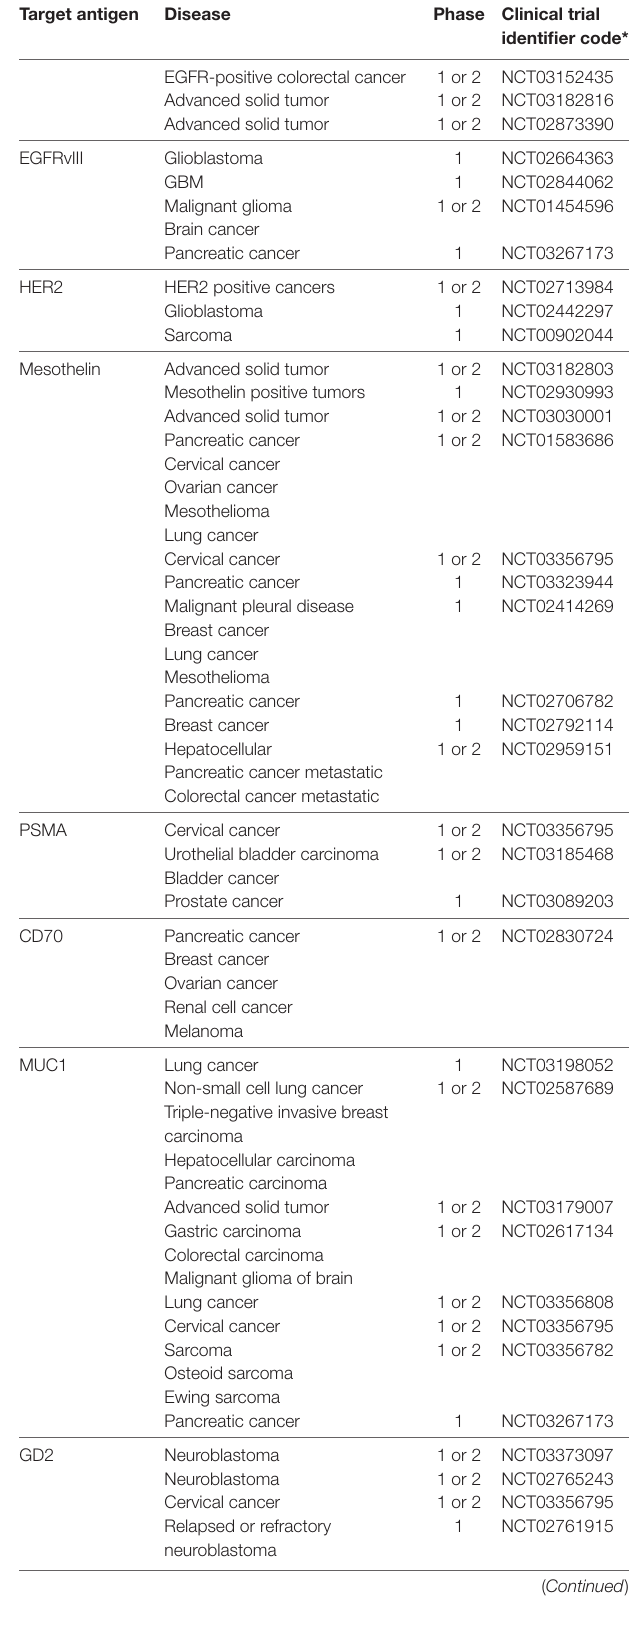
TAble 2 | Information of ongoing clinical trials registered in